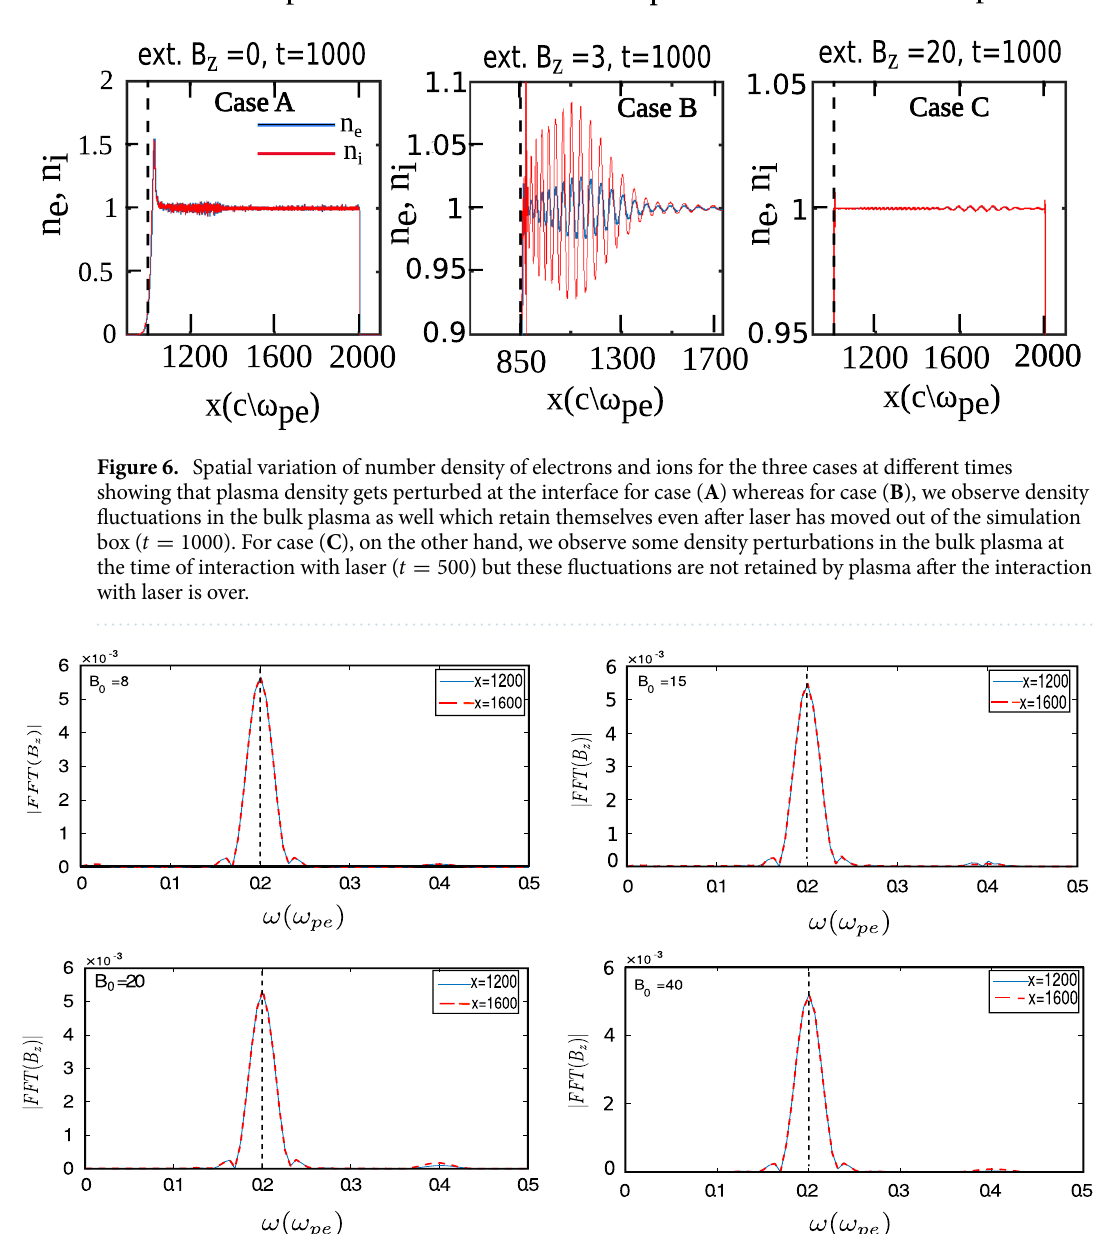
Figure 7. Fast Fourier Transform (FFT) of B z with time at two different locations in bulk plasma, showing that the peak frequency of electromagnetic wave does not change and it propagates unhindered in the plasma medium for different magnetic fields ( B 0 = 8, 15, 20, 40